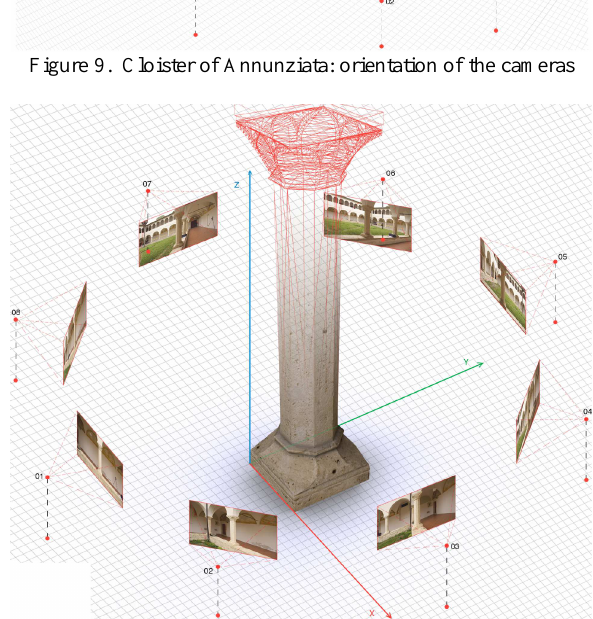
Figure 12. Cloister of Sant'Agostino: wireframe